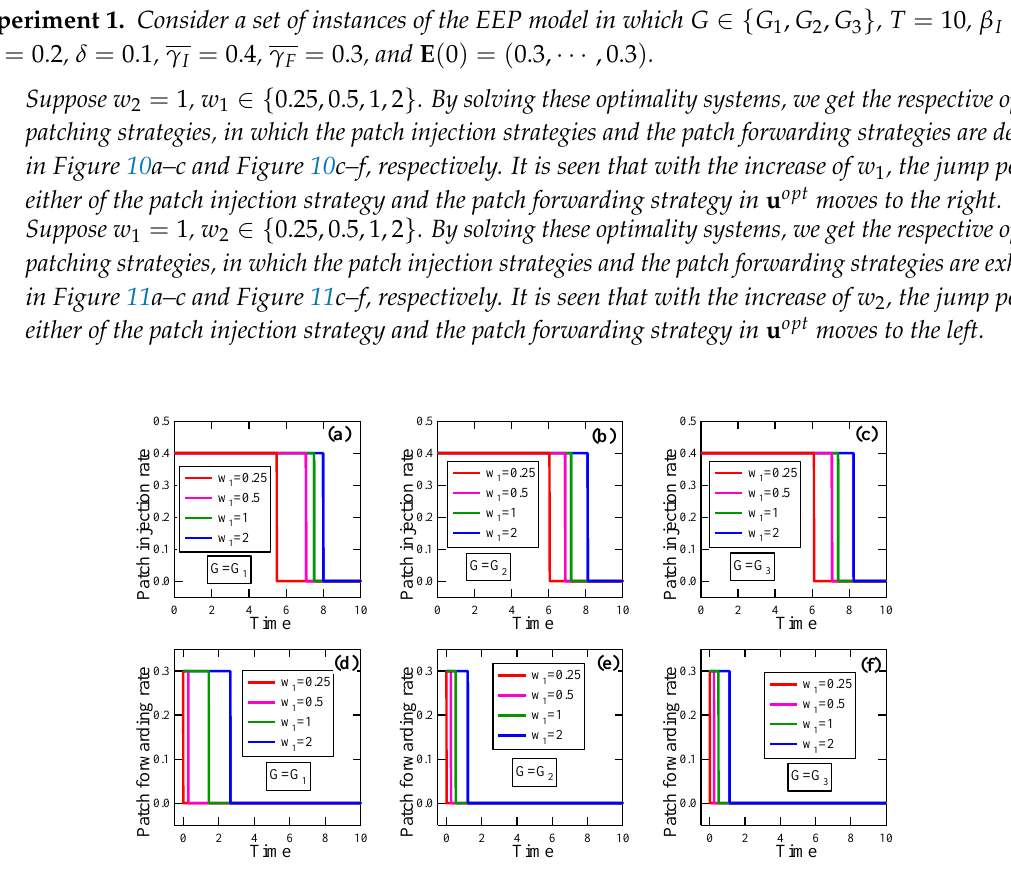
Figure 10. The experimental results in Experiment 1 about the effect of the loss coefficient on the optimal patching strategy. ( a ) Patch injection rate, G = G 1 ; ( b ) Patch injection rate, G = G 2 ; ( c ) Patch injection rate, G = G 3 ; ( d ) Patch forwarding rate, G = G 1 ; ( e ) Patch forwarding rate, G = G 2 ; ( f ) Patch forwarding rate, G = G 3